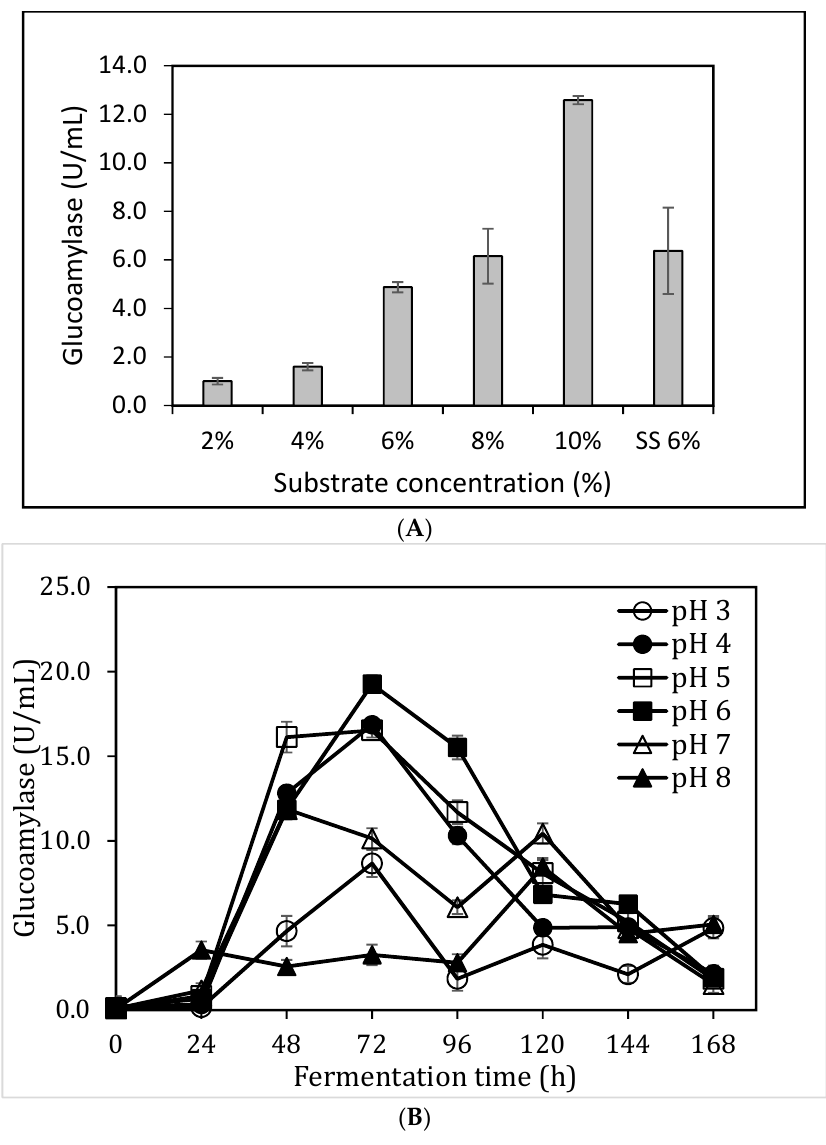
Figure 3. The effect of substrate concentration ( A ) and pH ( B ) on glucoamylase production. For the fermentation in ( 3A ): fermentation time 72 h, temperature 28 °C, with mineral solution C, no extra nutrients, no pH adjustment. For the fermentation in 3B: temperature 28 °C, 10% (w/v) sorghum bran, with mineral solution C, no extra nutrients, no pH adjustment.